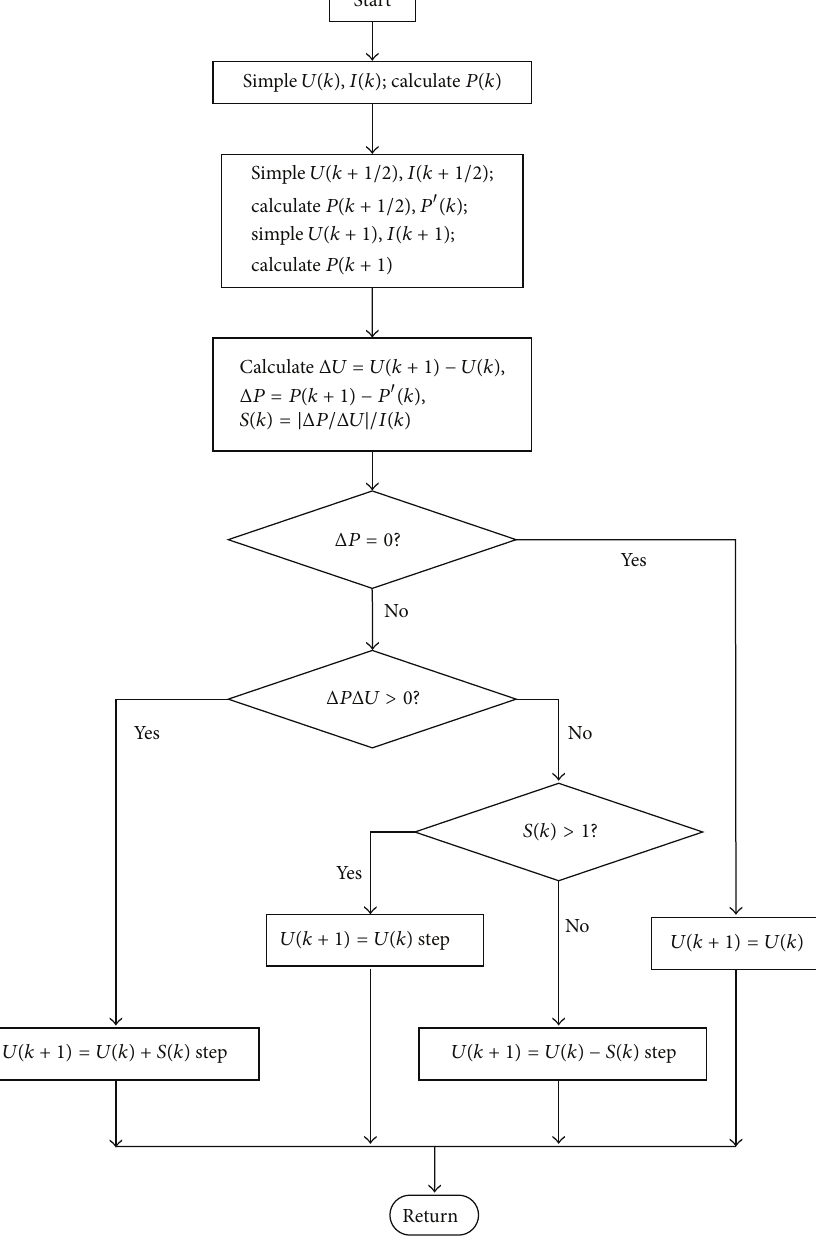
Figure 11: Flowchart of improved MPPT